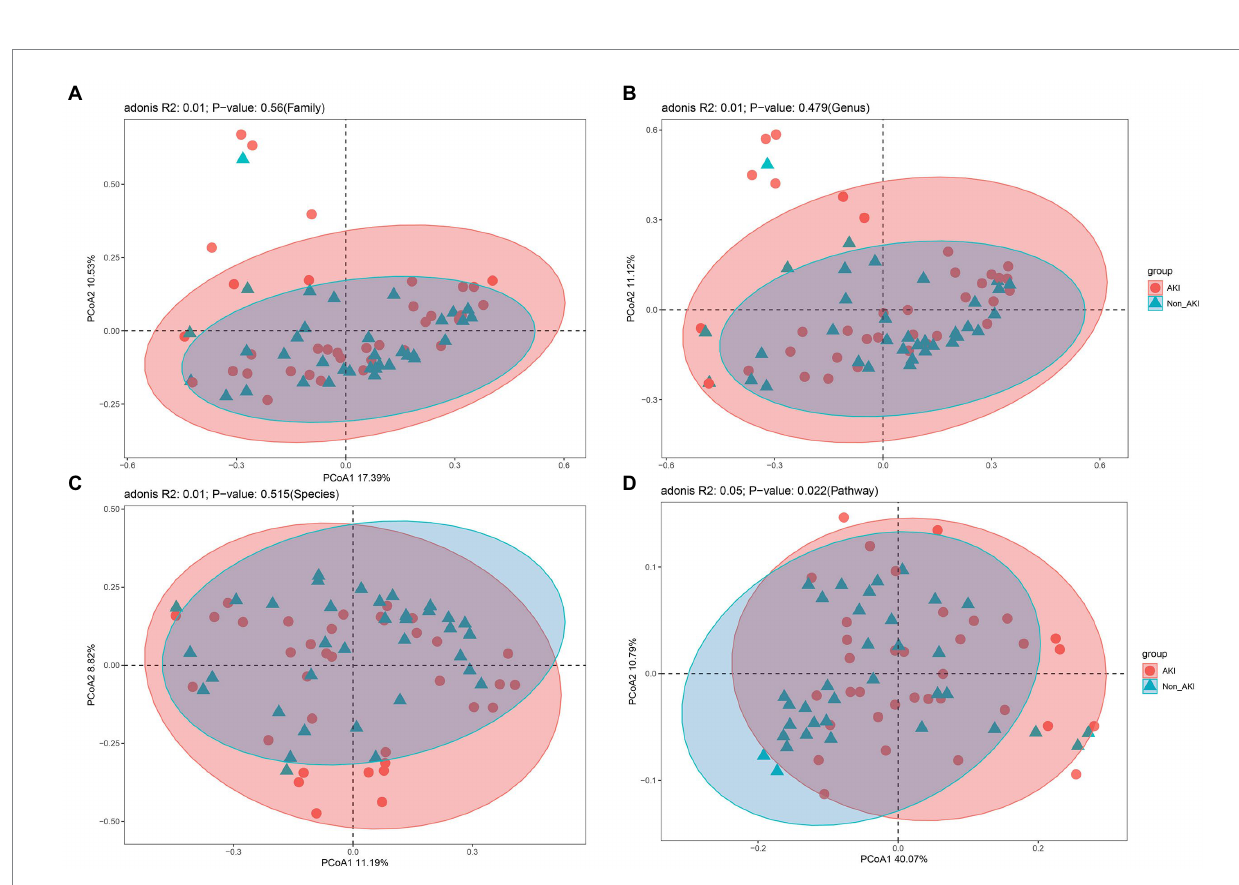
FIGURE 2 Comparison of beta-diversities using PCoA between the Non_AKI and AKI groups. (A) at the family level, (B) at the genus level, (C) at the species level, (D) at the pathway level. Threshold for statistical significance: p = 0.05.